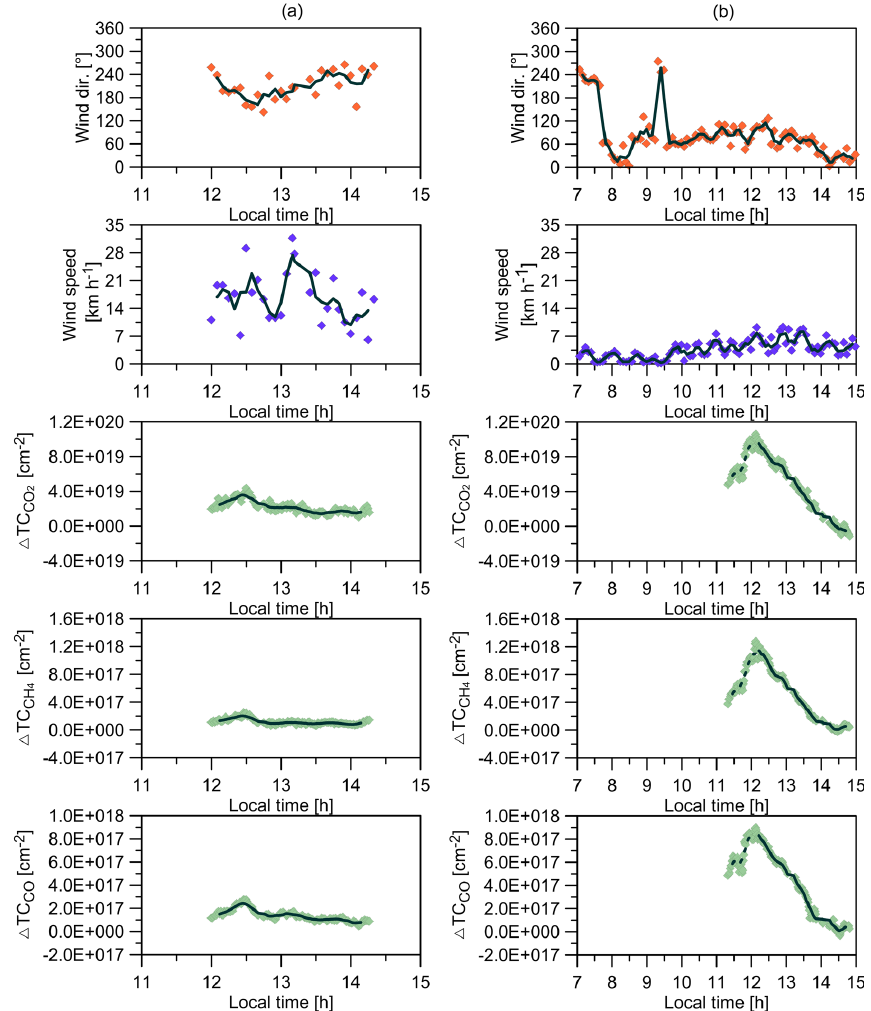
Figure 9. The difference between the TC values at the polluted and clean locations of FTSs on 4 April (a) and 25 April (b) . The wind speed and direction are also shown. Solid lines denote the 15min running average. Dashed lines denote the time interval when extrapolated input data from the clean location were used (see